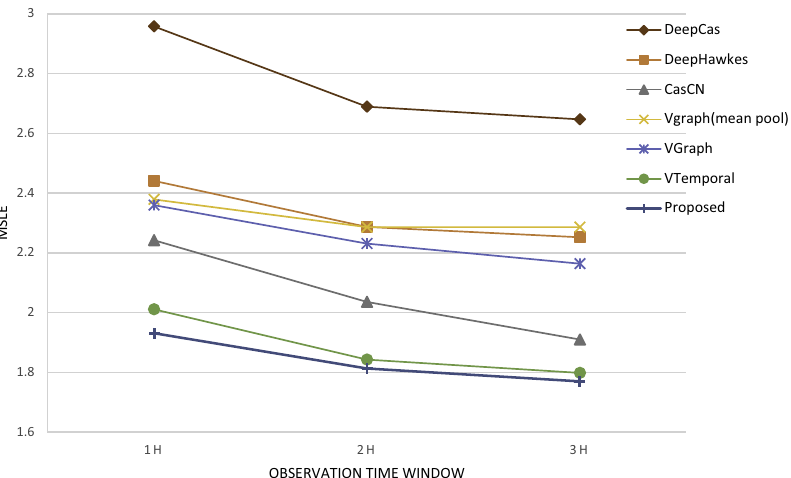
Figure 7. the line chart of performance comparison between baselines and model variants.